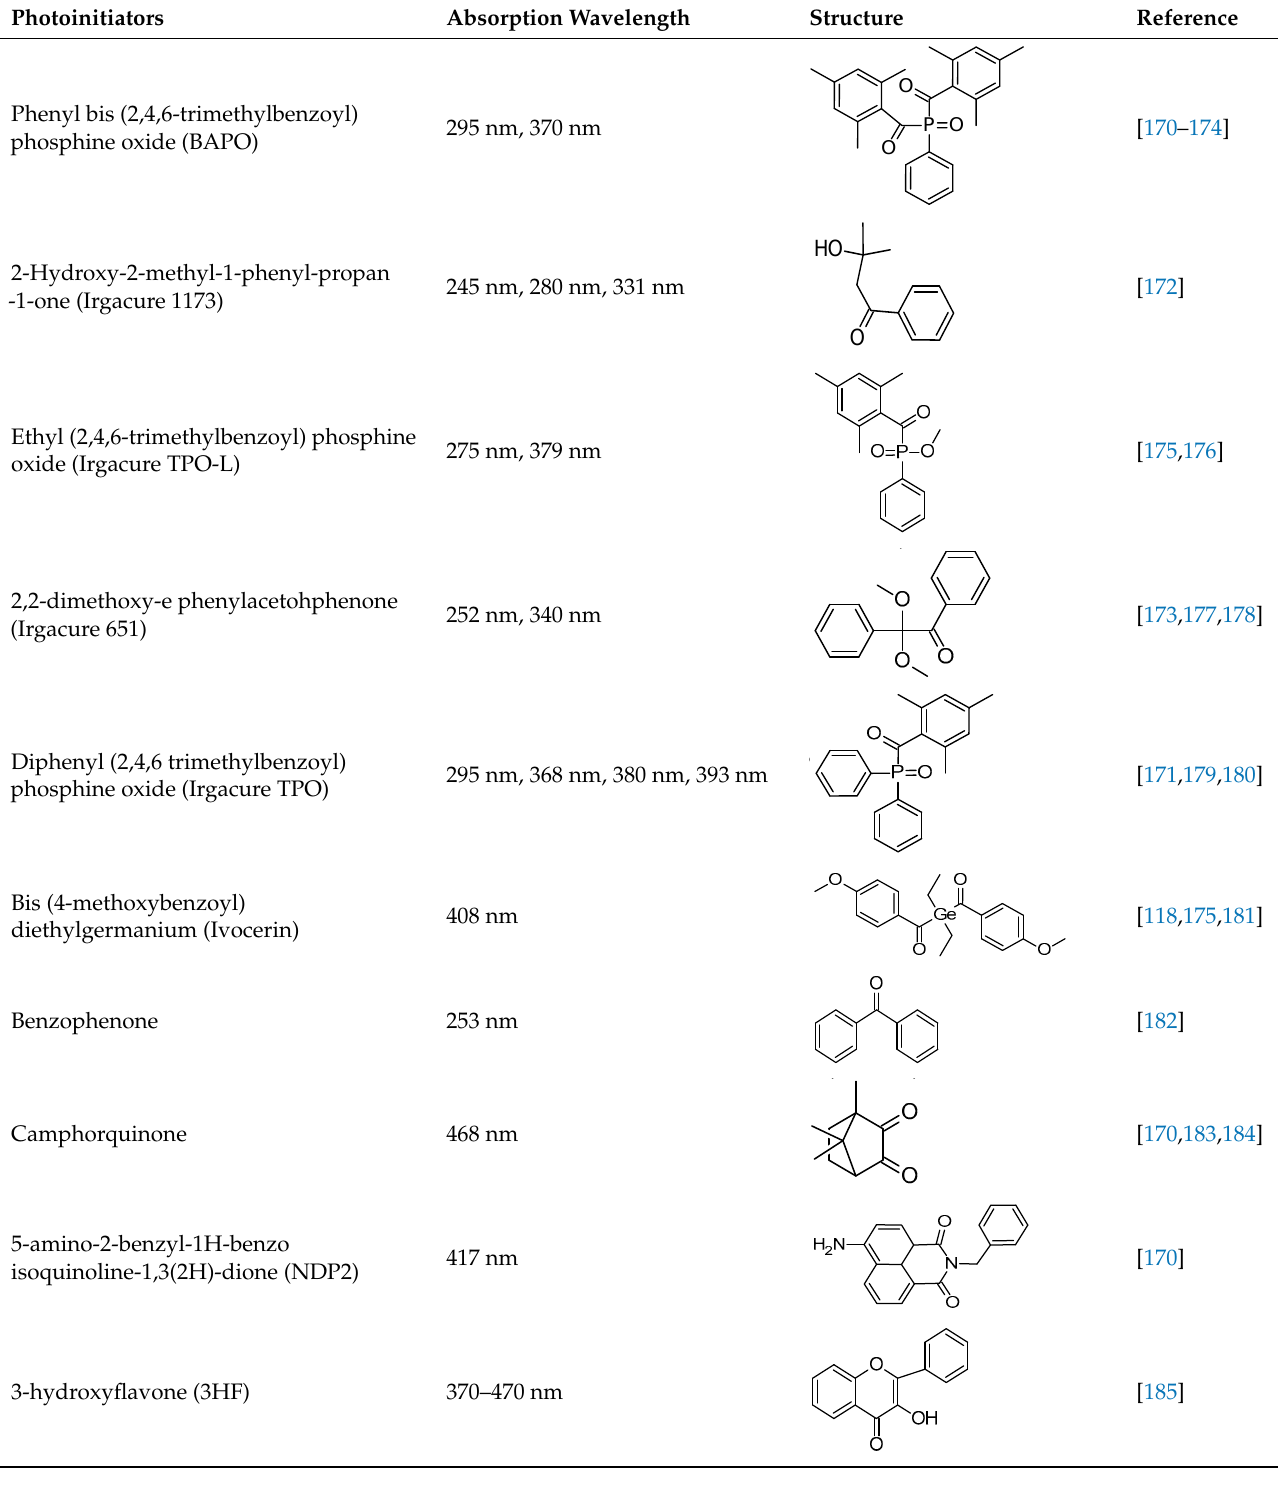
Table 4. List of radical photoinitiators used in vat photopolymerization 3D printing.